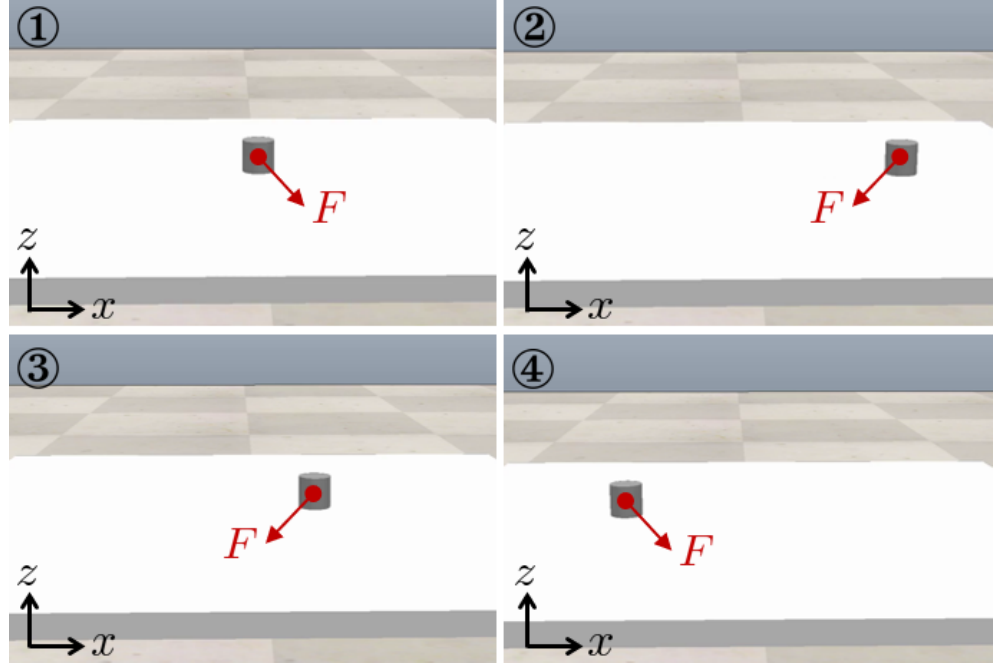
Figure 3. Snapshot of multi-point contact scenario: a cylinder is placed on a box and pressed down and pushed forward. When a cylinder reaches the end after pushing it in x direction ( 1 → 2 ), we push it in − x direction ( 2 , 3 ), and push it in x direction when it reaches the end ( 4